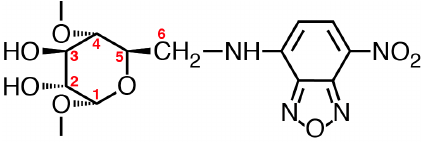
Figure 6. Structure of the NBDamine-modified glucose unit.